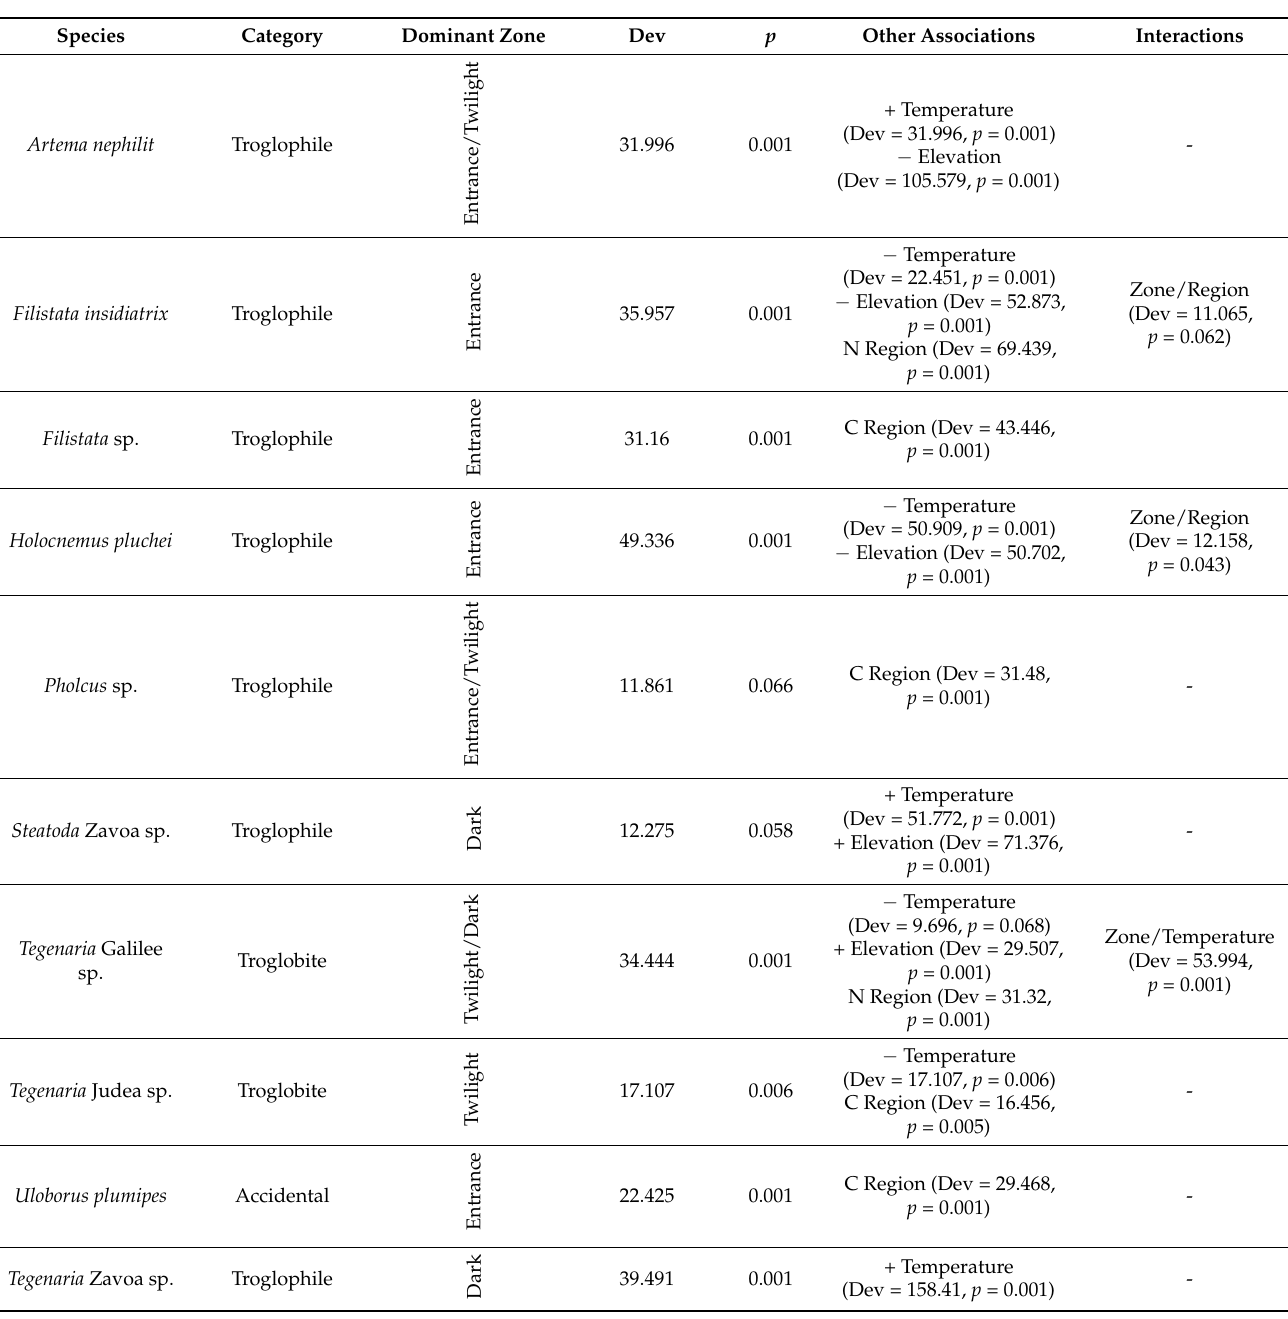
Table A1. Significant univariate MGLM results for the 10 species with significant associations to cave zones; deviance and probability are given for each. Other significant variables are listed, as well as interactions between zone and those variables. For the other associations, the nature of that association is given as “+” or “ − ” for positive or negative associations, respectively, and “N”, “C”, and “S” are given for prevalence in north, central, or southern geographical regions, respectively. The “category” column denotes whether that species is troglobite, troglophile, or accidental (see Gavish-Regev et al., 2021 [19] for the assignment of species to categories). The “dominant zone” column denotes which ecological zones(s) a species was mostly commonly found in. The abundance of these spiders across different cave zones is visualised in Figure